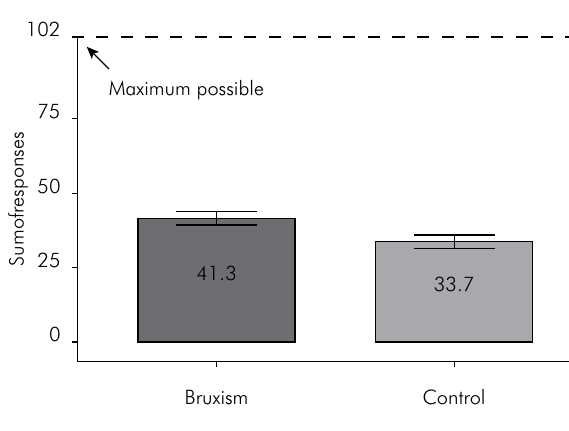
Figure. Graphic showing mean (± SEM) of the sum of the response levels to the trait anxiety scale for children. Ma- ximum possible = level 3 in response to all 34 questions (total scale = 102). (Student’s T test p =